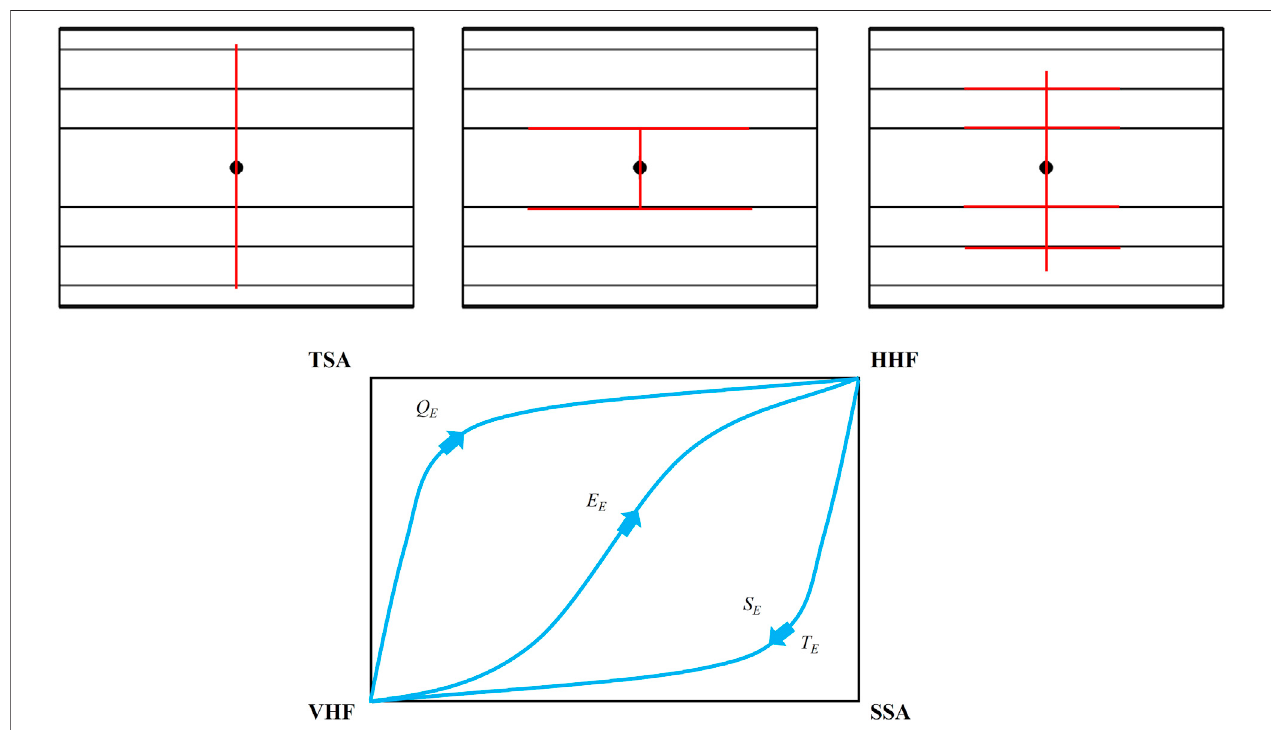
FIGURE14| Illustration ofthethreeHFgeometries: (A) averticalHF, (B) ahorizontalHF,and (C) HFnetwork. (D) SchematicevolutionofHFpropagationmodesin dimensionless space.